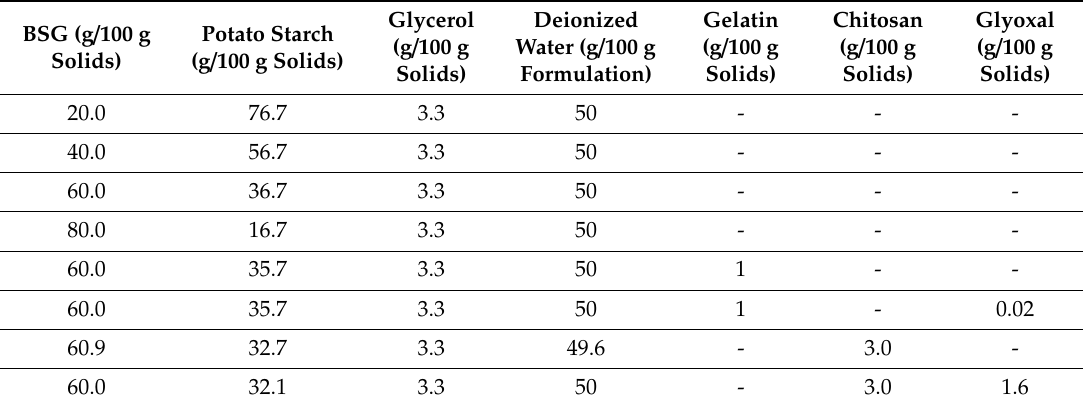
Table 1. Compositions of the di ff erent formulations used to prepare the trays. BSG: Brewer’s Spent